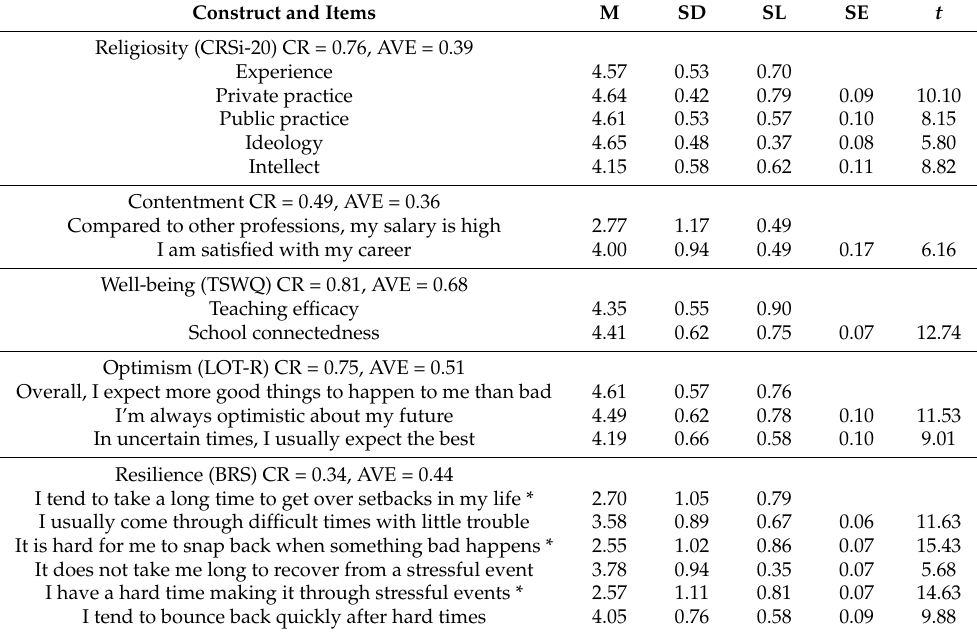
Table 4. Factor loadings for the measurement model.